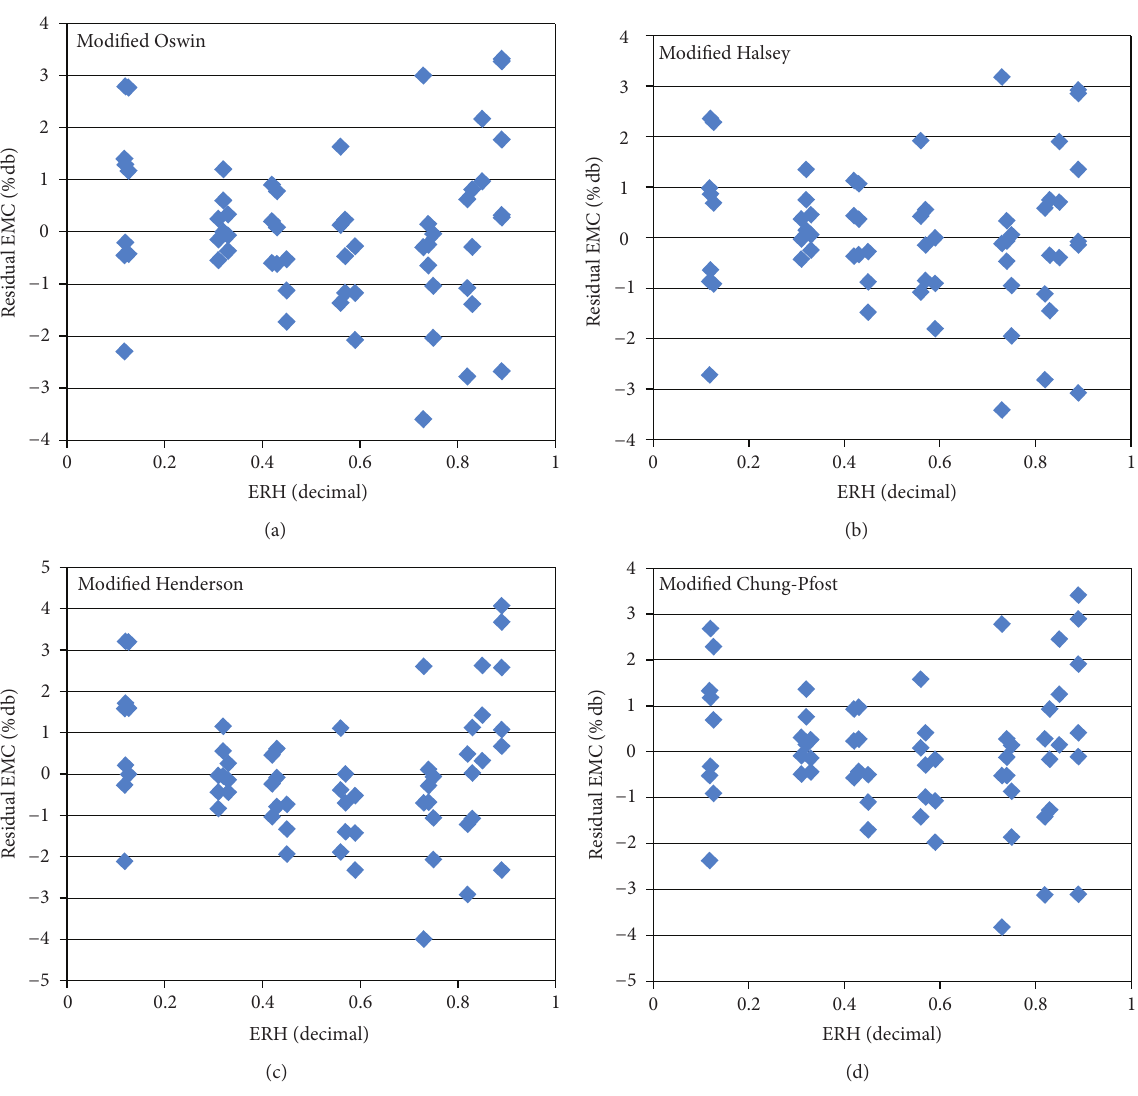
random distribution for both feedstocks when compared